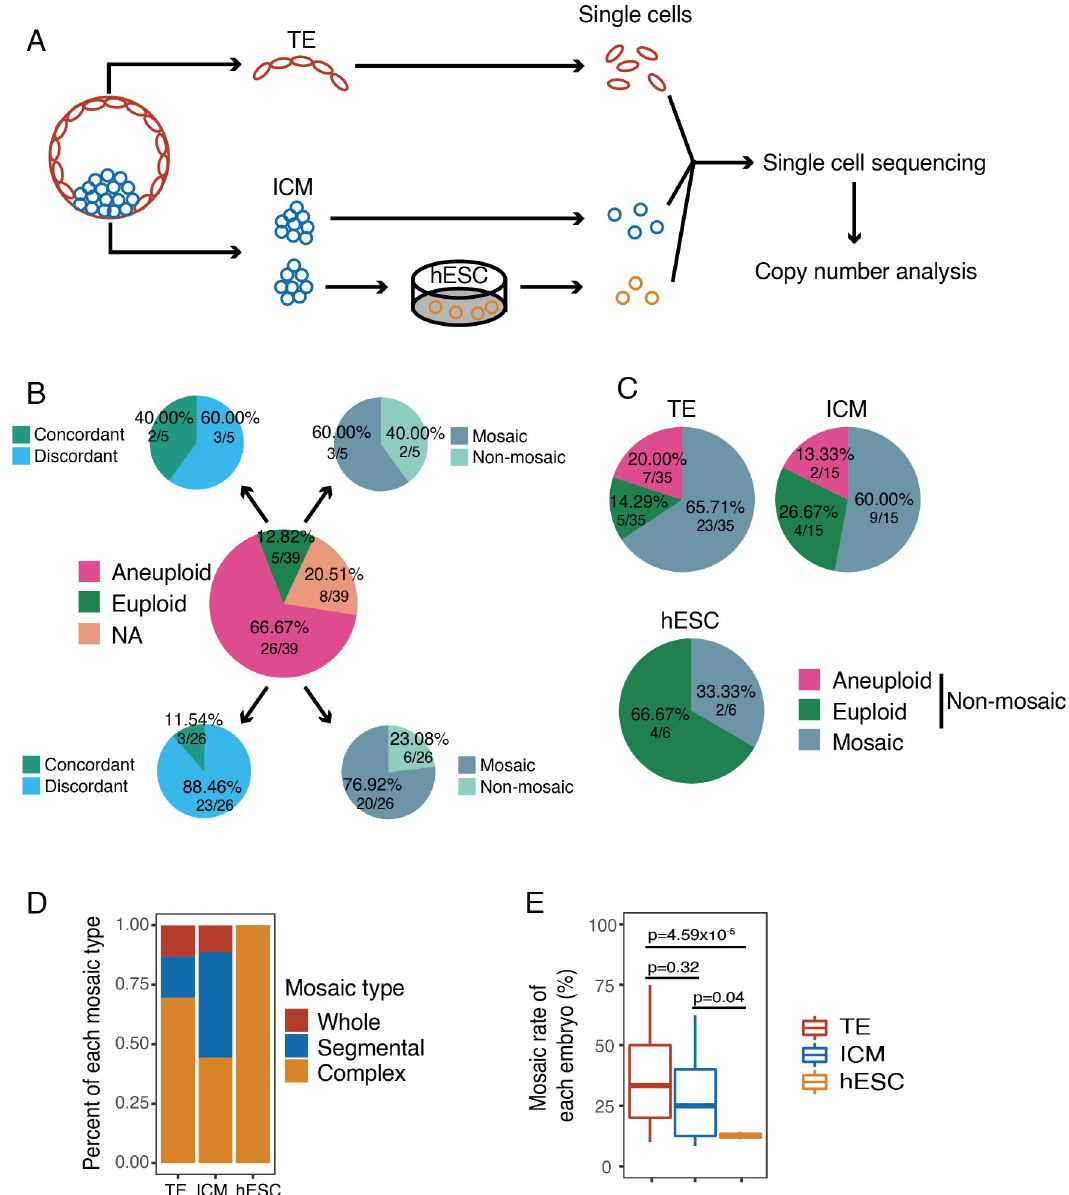
Fig 1. Analysis of chromosome copy number of human embryos. A) Experimental design of the current study. The ICM and TE cells were obtained by biopsy from the donated embryos (n = 39). For ICM cells, some of them were cultured in vitro to obtain hESCs. The TE, ICM and hESC were separated into single cells and sequenced. n, number of embryos. B) Pie charts showing the comparison between the single cell sequencing results and the initial PGT-A (multi-cell) results. The center pie showing the summary of the initial PGT-A results based on multi-cell analysis. The top left pie showing the percentage of karyotype concordant and discordant embryos from the initial PGT-A euploid embryos (single cell results vs. initial multi-cell results). If there were one or more cells showing different karyotype with the initial diagnostic results, the results would be identified as discordant. The bottom left pie showing percentage of karyotype concordant and discordant embryos from the initial PGT-A aneuploid embryos (single cell results vs. initial multi-cell results). The top right pie showing the percentage of mosaic and non-mosaic embryos detected in single cell sequencing from the initial PGT-A euploid embryos. The bottom right pie showing the percentage of mosaic and non-mosaic embryos detected in single cell sequencing from the initial PGT-A aneuploid embryos. C) Pie charts showing the percentage of aneuploid, euploid and mosaic embryos in TE, ICM and hESC. D) Rates of different types of mosaicism in mosaic TE (n = 23), ICM (n = 9) and hESC (n = 2). Whole: whole chromosome mosaic. Segmental: segmental chromosome mosaic. Complex: whole chromosome and segmental chromosome mosaic. n, number of embryos. E) Mosaic rates of mosaic TE (n = 23), ICM (n = 9) and hESC (n = 2) of each embryo. Only the mosaic TE, ICM and hESC were shown here. n, number of embryos.